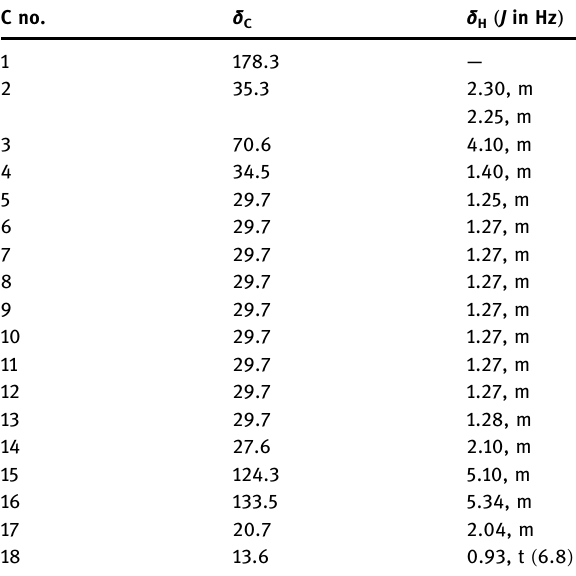
Table 2: 1 H and 13 C NMR spectral data of compound 5 in CDCl 3